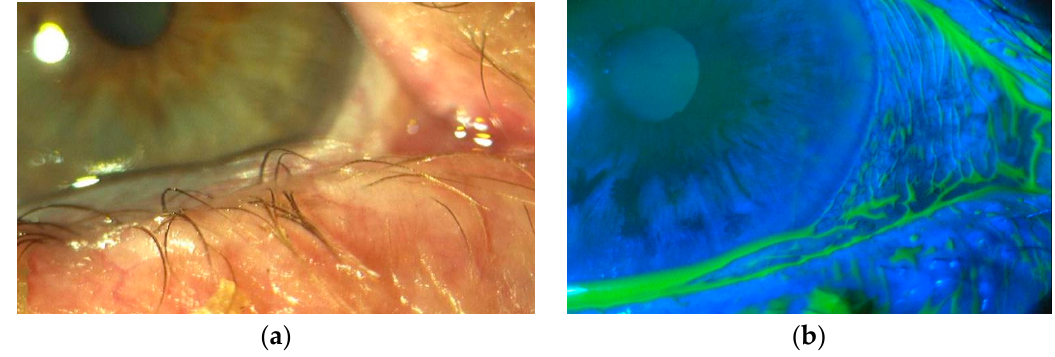
Figure 2. ( a ) Excessive conjunctiva sliding on the cornea. ( b ) After fluorescein staining. Tear film instability is a known cause of dry eye. Severity of symptoms depends on the extent of tear film disorder. Patients with severe tear film instability are more prone to ocular surface disease [1].